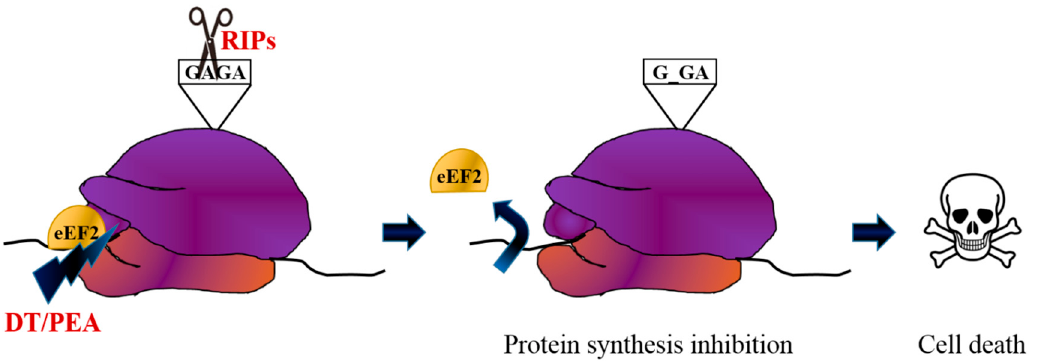
Figure 1. Toxin mechanisms of action. Ribosome inactivating proteins (RIPs) such as ricin and saporin depurinate a specific adenine in a universally conserved GAGA-tetraloop in the rRNA, while diphtheria toxin (DT) and pseudomonas exotoxin A (PEA) inactivate the eukaryotic elongation factor 2 (eEF2) by ADP ribosylation, both causing protein synthesis inhibition and thus cell death.